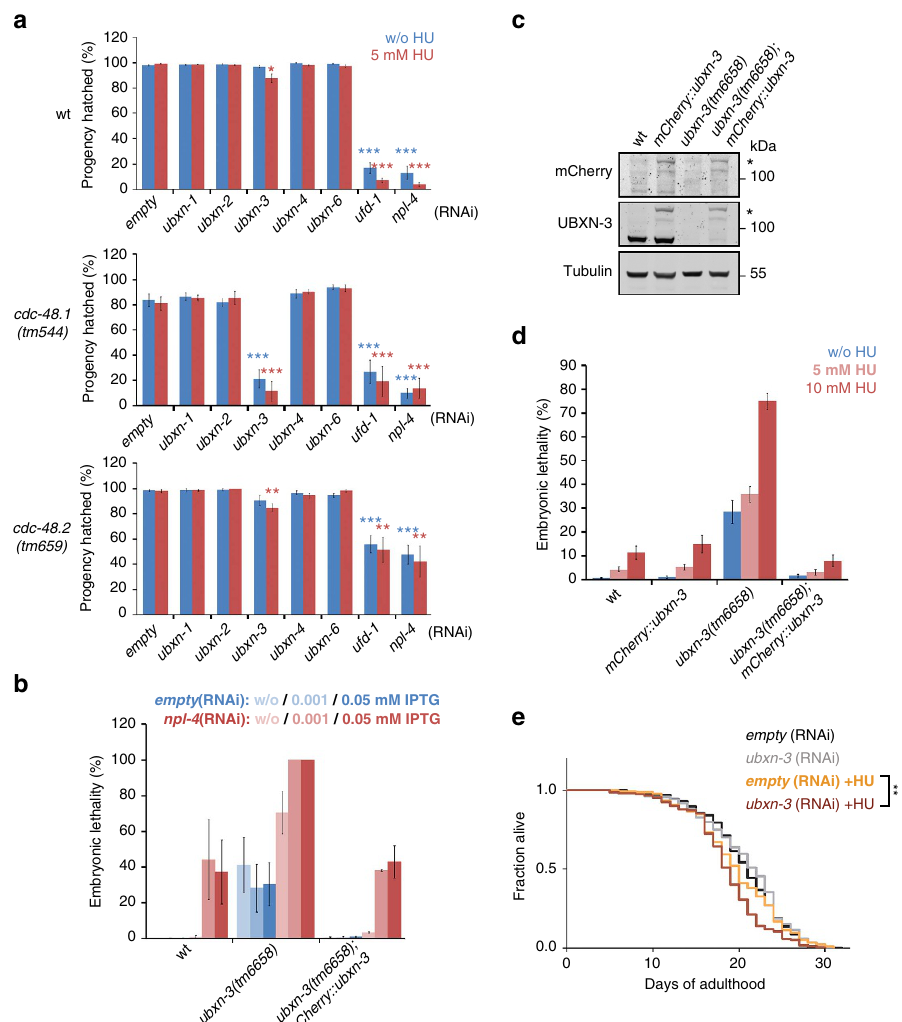
Figure 2 | Depletion of UBXN-3 results in DNA replication stress. ( a ) Developmental defects of worms RNAi depleted for indicated genes in respective genetic backgrounds exposed to 5mM hydroxyurea (HU). Mean values were calculated from eight independent replicates for wt and cdc-48.1(tm544) , or four replicates for cdc-48.2(tm659) . Error bars show s.e.m. Statistical significance refers to empty (RNAi) conditions without HU (blue asterisks), or with 5mM HU (red asterisks), respectively. ( b ) npl-4(RNAi) sensitivity of worms with indicated genotypes. Error bars show s.e.m. Mean values were calculated from four independent replicates. ( c ) Western blot analysis of mCherry, UBXN-3, and Tubulin protein levels in synchronized adult worms of indicated genotypes. Asterisk on the right marks the mCherry::UBXN-3 fusion protein. ( d ) Sensitivity of worms with indicated genotypes towards distinct HU concentrations. Graph shows mean embryonic lethality of six replicates. Error bars show s.e.m. ( e ) Adult lifespan after RNAi depletion of control ( empty ) or ubxn-3 with or without 10mM HU. Data were collected from five replicates, in sum representing mean lifespan of at least 165 individuals per condition. In ( a ) the single asterisk indicates a P value of r 0.05, the double asterisk r 0.001 and the triple asterisk indicates P values of r 0.0001 in Student’s t -test. In ( e ) the double asterisk indicates a P value of r 0.01 in Mantel–Cox